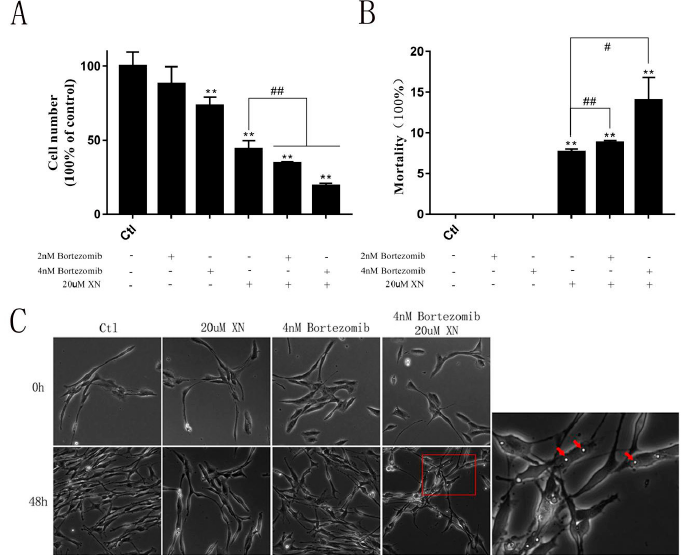
Figure 10. Effect of bortezomib on XN (20 uM)-induced inhibition of C6 cell proliferation. The C6 cells were pretreated with 2 nM or 4 nM bortezomib, and inhibitor of the LONP1 for 1.5 h before the co-treatment with XN for another 48 h. ( A , B ) The cell viability and the cell deaths were measured by SRB assay. ( C ) The morphology changes were captured by a Leica Microsystems microscope (200 × g magnification), and intracellular vacuoles were marked by red arrows. All data presented are the mean ± SEM from three independent experiments. ** p < 0.01 vs. control groups. # p < 0.05, ## p < 0.01 vs. XN-treated group.